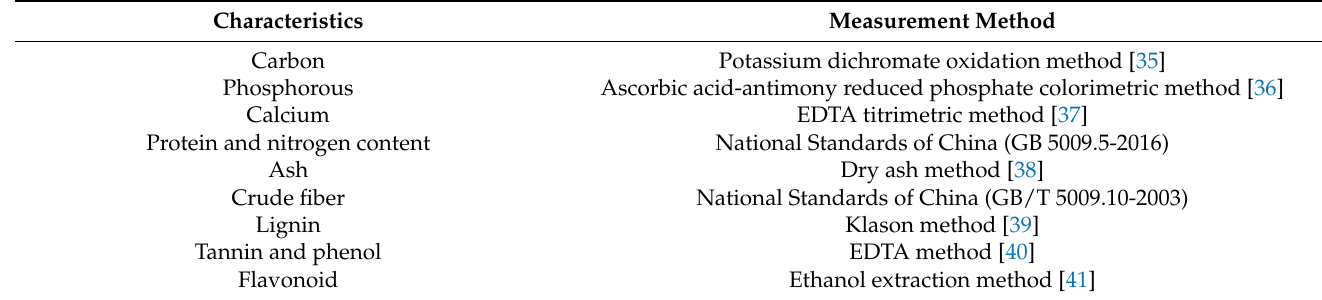
Table 1. Measurement of chemical characteristics of decaying leaf